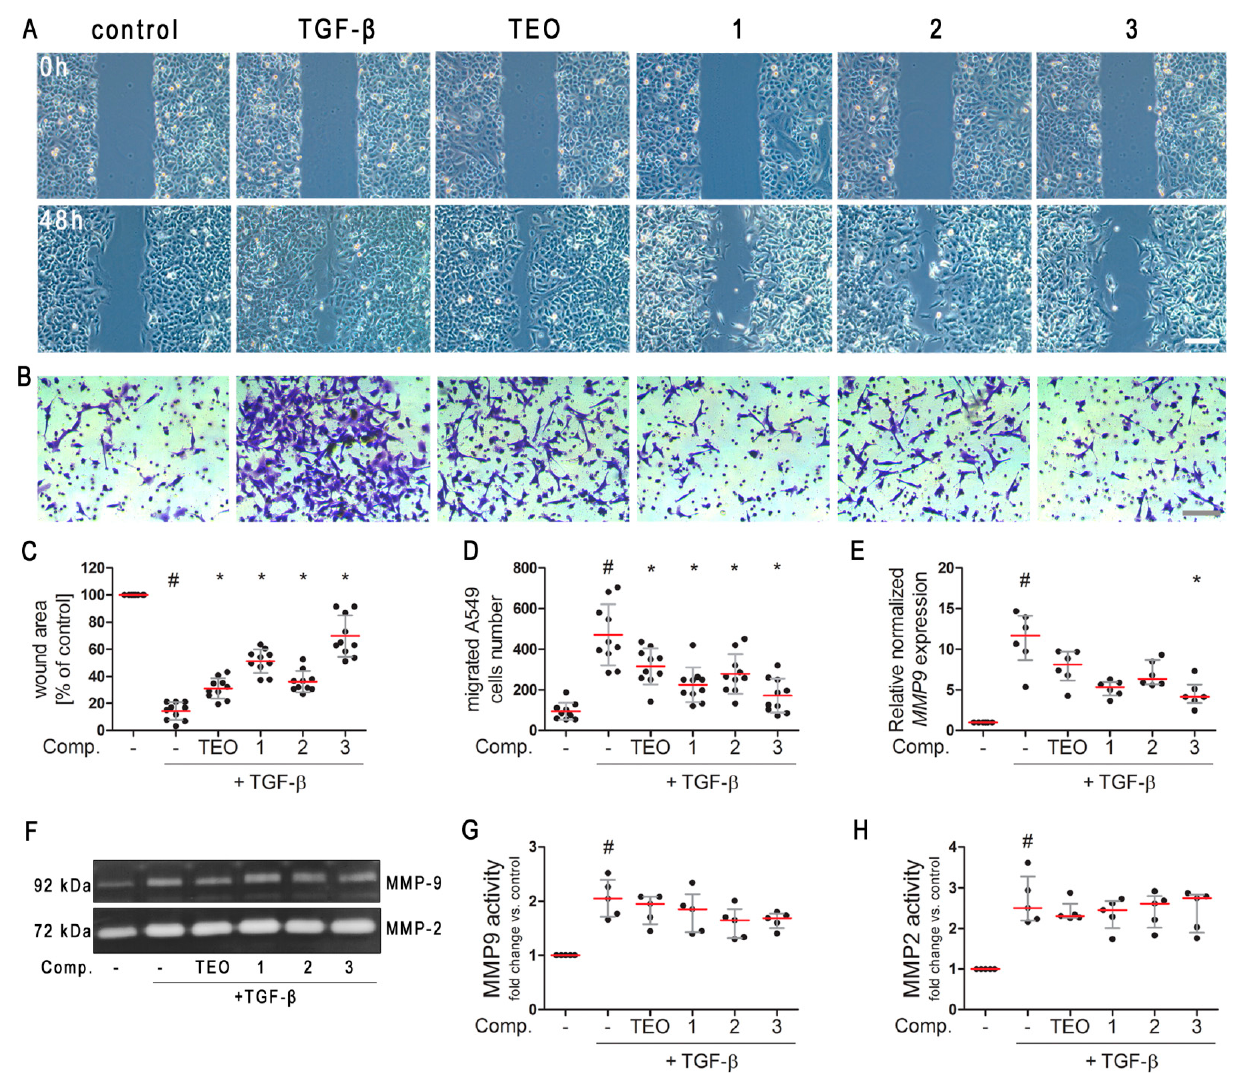
Figure 5. Pan-PDE inhibitors diminish TGF- β -induced migration of alveolar epithelial type II cells. A549 cells were cultured overnight and then serum-deprived for 24 h. 1 , 2 , 3 , or TEO (10 µ M) was administrated 1 h before TGF- β (5 ng/mL) treatment for 48 h incubation. Cell migration was examined via the wound healing assay ( A , C ) and the Transwell system ( B , D ). ( A ) Representative microphotographs (100 × magnification) illustrating the wound area at the beginning of the experiment (0 h) and after 48 h of TGF- β -induced A549 cells’ incubation in the presence of 1 , 2 , 3 , or TEO. Scale bar = 200 µ m. ( C ) Quantification of wound area in comparison to non-treated control cells after 48 h incubation. Horizontal lines represent the mean value ( ± SD), n = 10 (ANOVA with Dunnett’s post-hoc test). ( B ) Representative microphotographs (100 × magnification) demonstrating migrated A549 cell numbers stained with crystal violet. Scale bar = 200 µ m. ( D ) Migrated cells were counted in randomly selected fields of view. Horizontal lines represent the mean value ( ± SD), n = 10 (ANOVA with Dunnett’s post-hoc test). ( E ) Expression of MMP9 gene in comparison to 18sRNA was quantified by RT-qPCR analysis. Horizontal lines represent the median with interquartile range, n = 6 (Kruskal–Wallis test with Dunn’s post-hoc test). ( F ) Representative zymogram showing MMP2 and MMP9 enzymatic activity. ( G , H ) Quantification of MMP9 ( G ) and MMP2 ( H ) corresponding bands, optical density normalized to basal control conditions. Horizontal lines represent the median with interquartile range, n = 5 (Kruskal–Wallis test with Dunn’s post-hoc test). The results were considered statistically significant at the p -level of 0.05, against the control (#) and TGF- β (*) conditions. In order to investigate the potential involvement of matrix metalloproteinase 9 (MMP9) in the pan-PDE inhibitors’ effect on TGF- β -induced A549 migration, we next